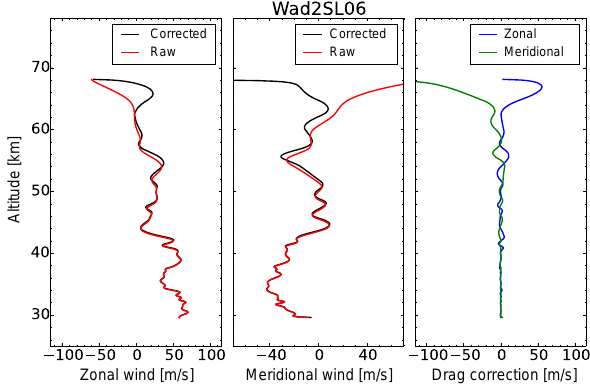
Figure 4. Zonal and meridional wind speed for SL06, without the wind correction (red) and including the wind correction (black) for the zonal (left panel) and meridional wind (middle panel). The cor- rection terms are plotted separately in the right panel. See text for more